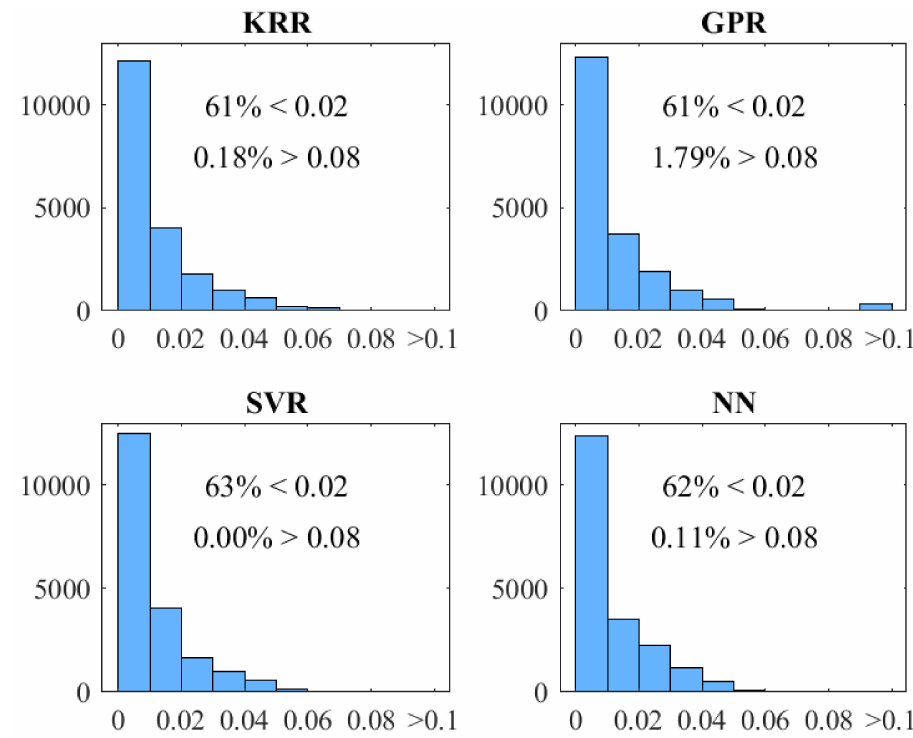
Figure 8. Histograms of the relative errors for all bands in the spectral range between 661 and 710 nm between the spectra of the “reference data” from VDB and the retrieved Rrsn − SICF ( λ ) for each MLRA trained. The X -axis is the relative error and the Y -axis are the number of counts.